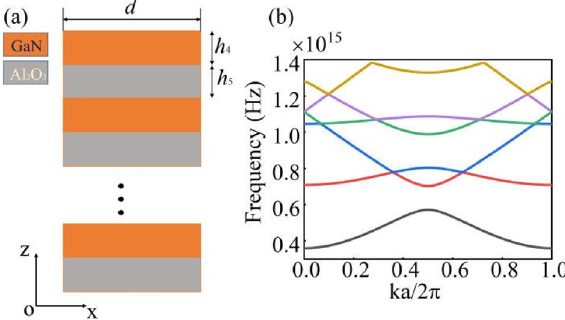
Figure 5. ( a ) Schematic of the multilayers considered here, we apply Floquet periodicity conditions at the both sides of structure. ( b ) The two-dimensional structure of energy bands based on scanning of the Brillouin zone with the proposed